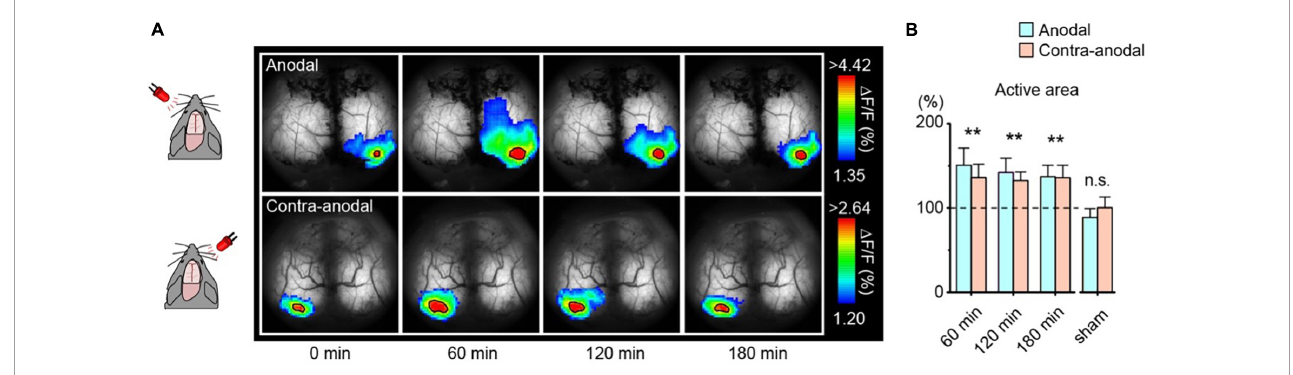
FIGURE8 Enlargement of the visually evoked area after transcranial direct-current stimulation (tDCS). (A) Transcranial imaging of visual flash response after tDCS. The flash responses to left and right-eye are plotted as anodal and contra-anodal, respectively (ipsilateral responses are masked out). The color range is between mean + 1 SD and the peak value of the baseline visual evoked response. Solid black borders demarcate areas exceeding 90% of the baseline visual evoked response (active areas). (B) Comparison of the area of the visual-evoked region after tDCS. Data is mean + s. e. m. ** p < 0. 01. [Modified from Monai et al.